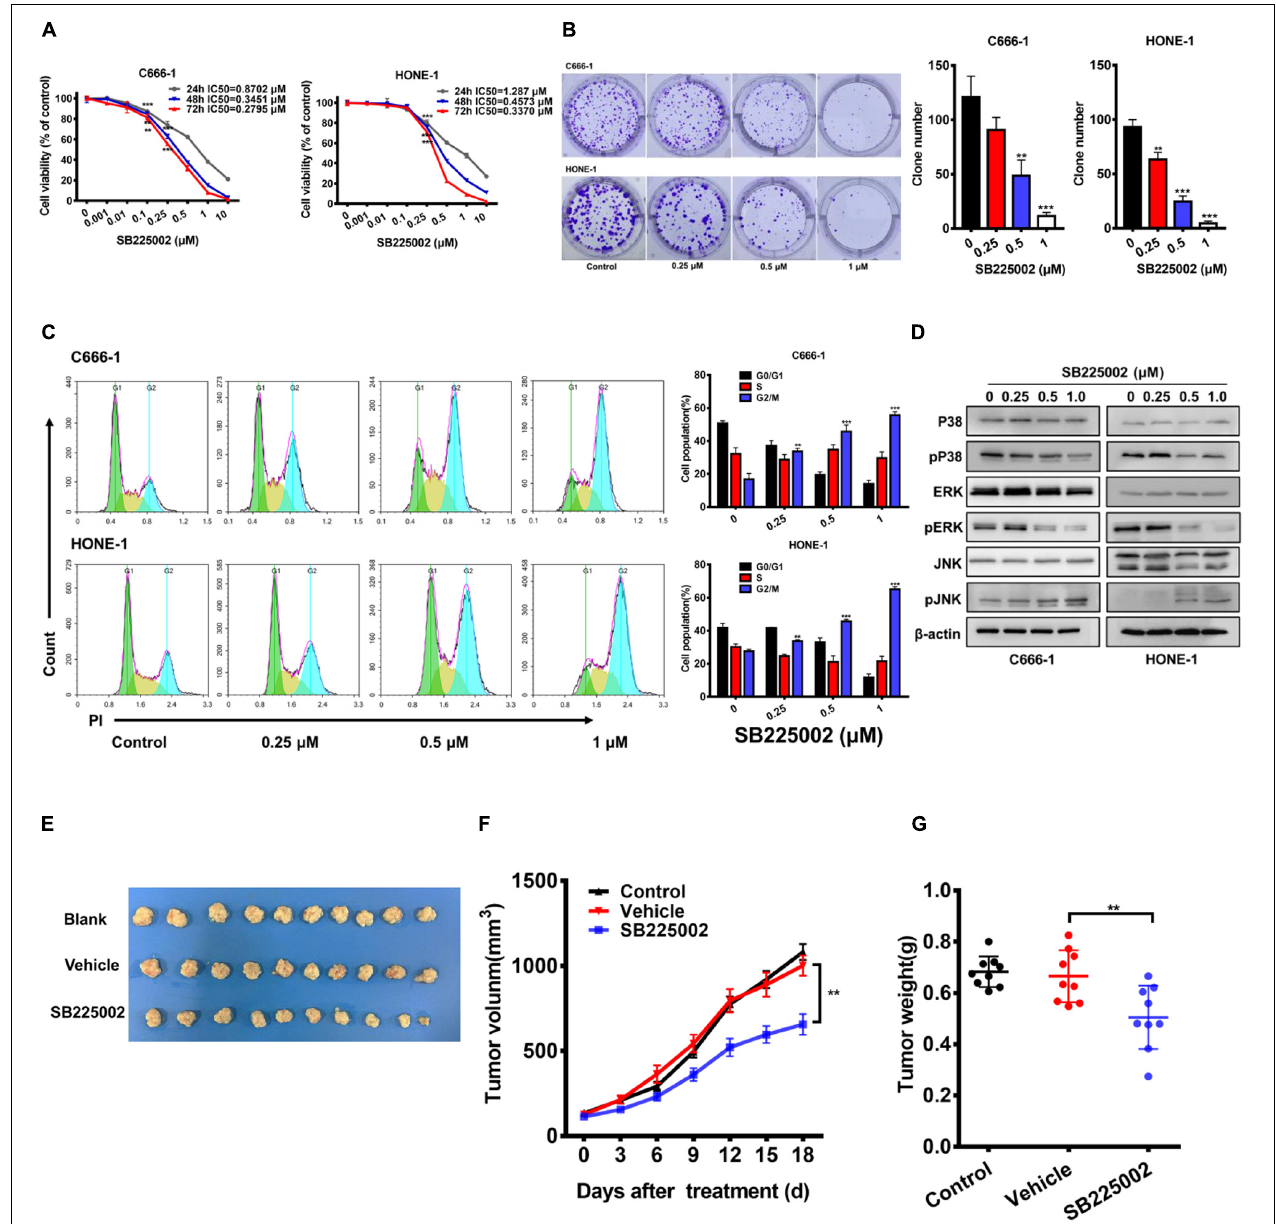
FIGURE 2 | SB225002 suppresses tumorigenesis in NPC cells in vitro and in vivo . (A) SB225002 inhibited cell proliferation. C666-1 and HONE-1 human NPC cells were treated with SB225002 for (24, 48, and 72 h), cell viability was evaluated by CCK8 assay (** p < 0.01; *** p < 0.001; Student’s t -test). Values represent mean ± SD ( n = 5). (B) The effects of SB225002 on colony formation in C666-1 and HONE-1 cells for 10-12 days. The colonies were counted and shown with histograms (** p < 0.01; *** p < 0.001; Student’s t-test). Values represent mean ± SD (n = 3). (C) Cell cycle analysis of C666-1 and HONE-1 cells after SB225002 treatment for 8 h (** p < 0.01; *** p < 0.001; Student’s t -test). Values represent mean ± SD (n = 3). (D) The expression of p38, p-p38, ERK, p-ERK, JNK and p-JNK in C666-1 and HONE-1 cells pre-treated with SB225002 for 2 h determined by western blot analyses and β -actin was employed as a standard. (E–G) C666-1 cells were established subcutaneous in female BALB/c mice and SB225002 at 10 mg/kg and vehicle administration once daily were started 5 days after inoculation. Tumor volumes and tumor weights were recorded every three days (seven mice per group). (E) Representative images of the xenograft tumors in three groups. (F) The growth curves of the tumors in groups were presented. Data are shown as the mean tumor volume ± SD ( n = 7; ** p < 0.01; two-way ANOVA). (G) The antitumor effects of SB225002 on the tumor weight in groups were shown as mean ± SD ( n = 7; ** p < 0.01; Student’s t -test).